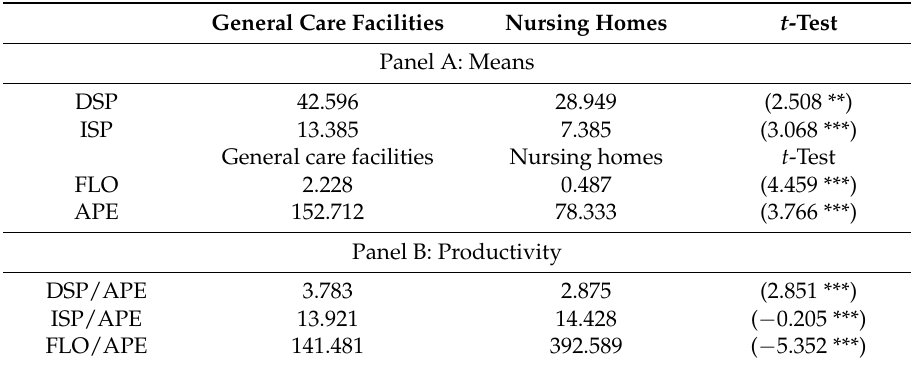
Table 3. Tests of the significance of